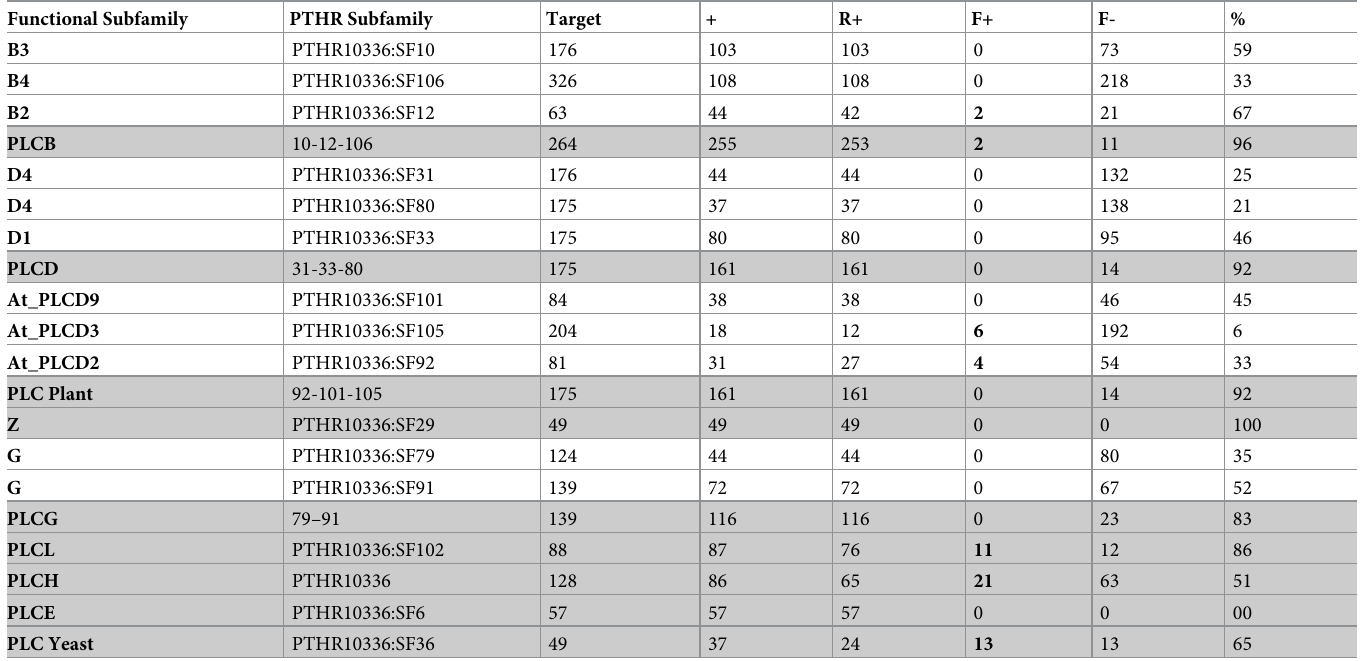
Table 1. Panther classification of PLC case.